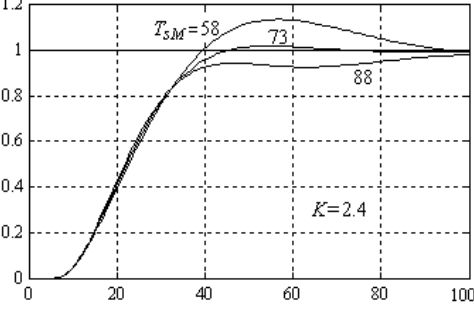
Figure 14. Responses y ( t ) to a unit step reference for K M = 1.5, τ M = 8 and T sM = 58; 73; 88.